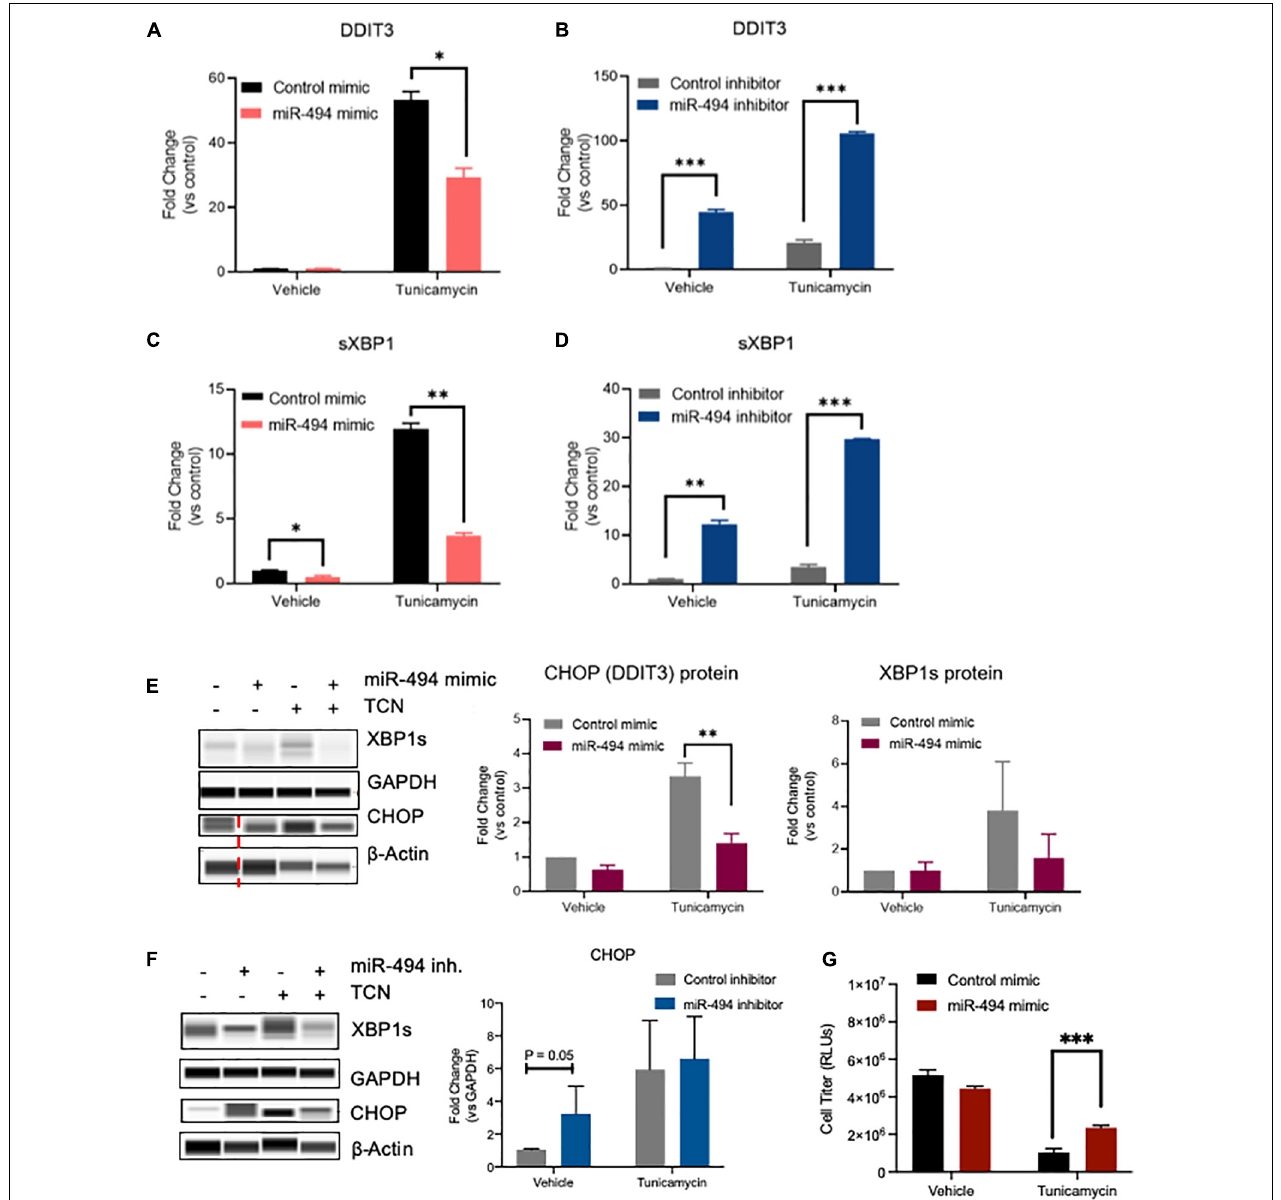
FIGURE 2 | miR-494 is a negative regulator of ER stress in vitro . Relative mRNA expression of ER stress responsive genes as measured by qRT-PCR. (A,B) DDIT3 (CHOP), (C,D) spliced XBP1 in HUVECs treated with 10 µ g/mL TCN 48h after transfection with (A,C) miR-494 mimic or (B,D) miR-494 inhibitor. Gene expression is normalized to GAPDH and mean fold changes compared to control treatments are shown. (E,F) Simple Western blot analysis of HUVECs transfected with miR-494 mimic or control (24 h) (E) or miR-494 inhibitor or control (F) followed by TCN (10 µ g/mL) for 24 h. (G) Cell viability in HUVECs as treated in (A) Vertical dotted red line indicates non-adjacent lanes. Graphs are mean + SEM fold changes of biological replicates from n = 3 independent experiments. ∗ P < 0.05, ∗∗ P < 0.01, ∗∗∗ P < 0.001 by two-tailed Student’s T